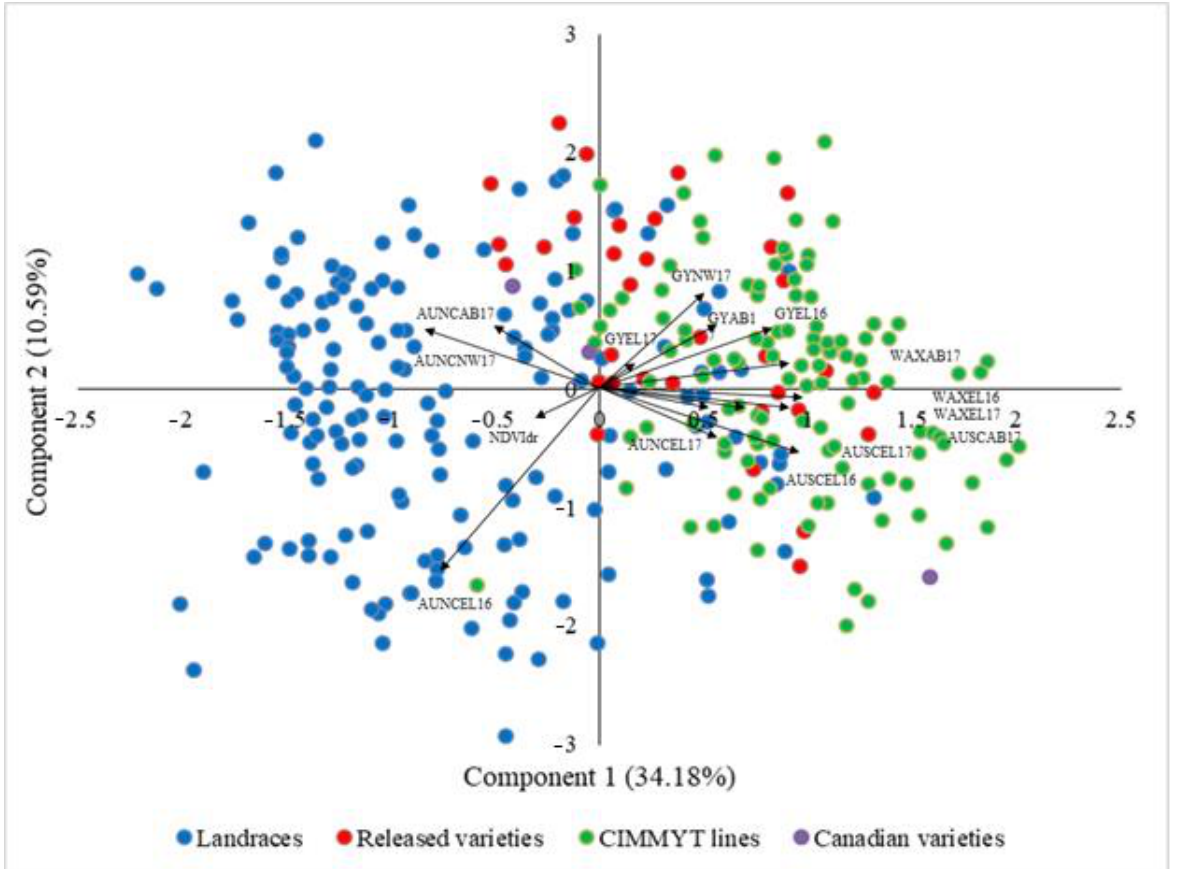
Figure 2. A biplot generated for grain yield, waxiness, and chlorophyll-related traits evaluated in four field experiments in 2016 and 2017. Abbreviations: AUNC = Area under NDVI curve, AUSC = Area under SPAD curve, NDVIdr = NDVI derived from UAV/drone data, WAX = Waxiness, GY = Grain yield, EL = Elora, NW = National Wheat Research Program (NARC, Nepal), AB = Agricultural Botany Division (NARC, Nepal). The numbers 16 and 17 correspond to the year of experimentation, CIMMYT = International Maize and Wheat Improvement Center.